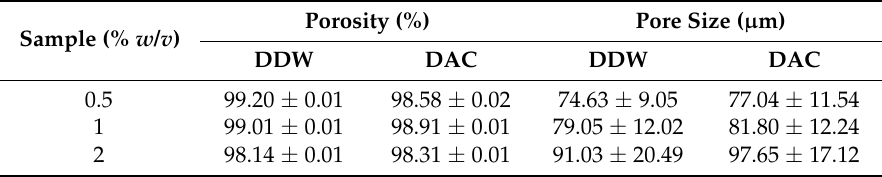
Table 3. Porosity and pore size of